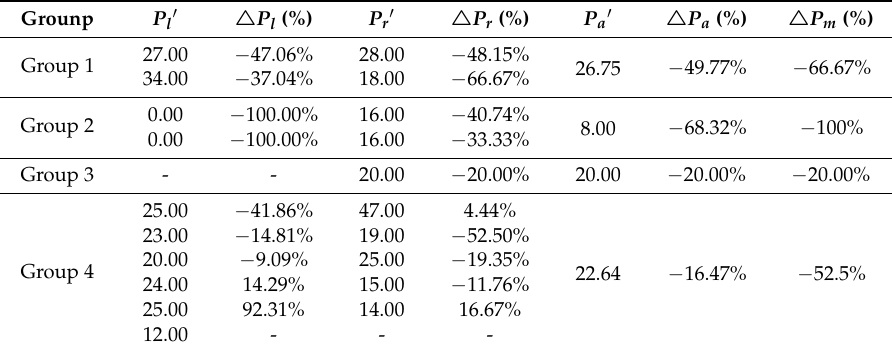
Table 2. The change percentage of graphical insulator overhang after